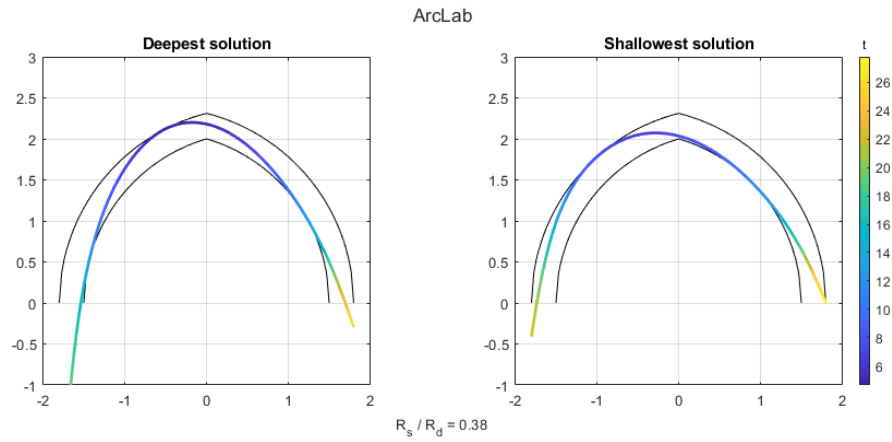
Figure 8: Deepest and shallowest solutions for a pointed arch subjected to vertical and horizontal loads